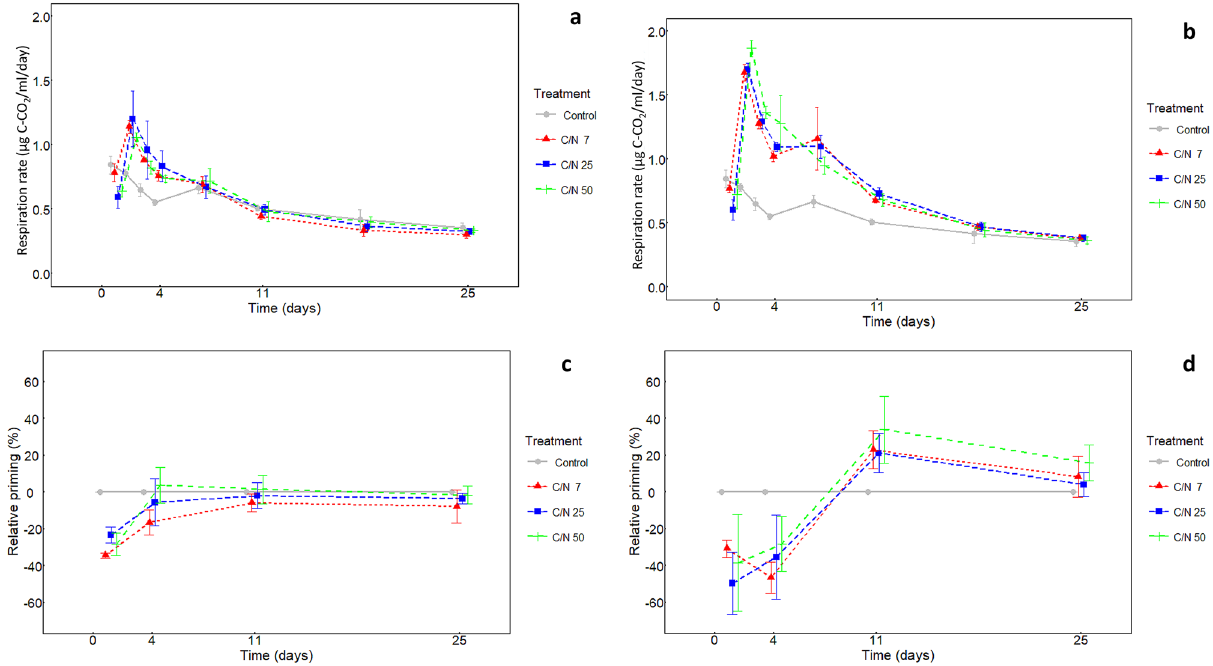
Figure 1. Respiration rate of control samples and samples amended by artificial exudates with different C/N ratios ( A ) in concentration of 2% of total DOC and ( B ) in concentration of 5% of total DOC during 25 days incubation. ( C ) Relative priming effect on DOC induced by artificial exudates with different C/N ratios in concentration of 2% of total DOC and ( D ) in concentration of 5% of total DOC during 25 days incubation (means, ± standard deviations, n =